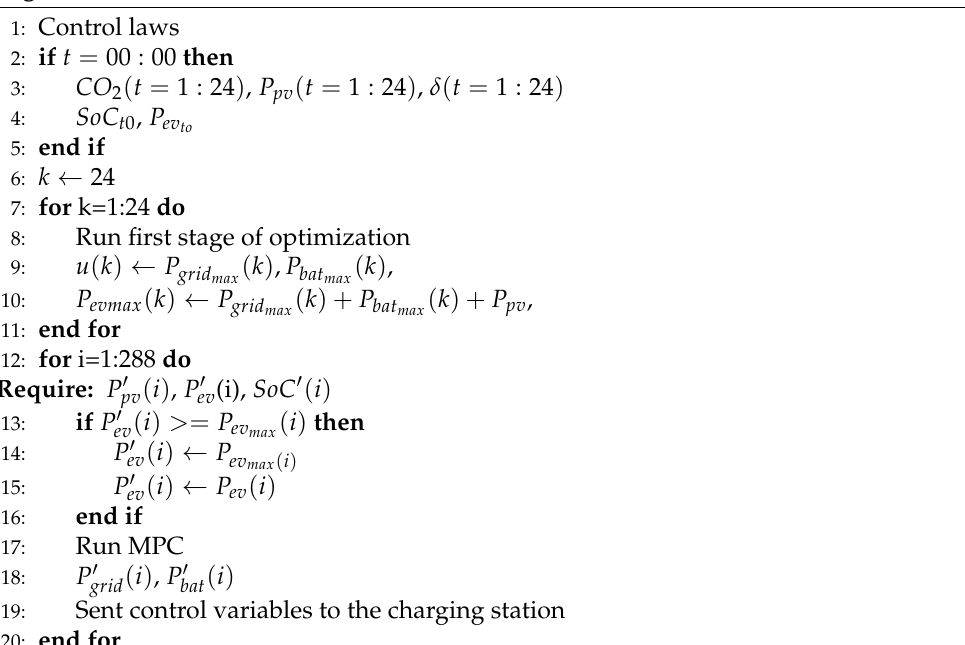
Algorithm 1 Real-time